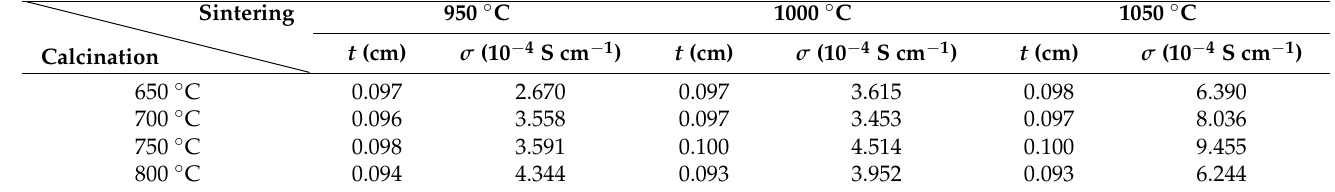
Figure 6. Impedance spectra for LASTP-750 pellet sintered at ( a ) 950 ◦ C, ( b ) 1000 ◦ C, ( c ) 1050 ◦ C, and ( d ) temperature dependence of LASTP-750 ionic conductivity. Table 2. Thicknesses and ionic conductivities of pellets sintered at various